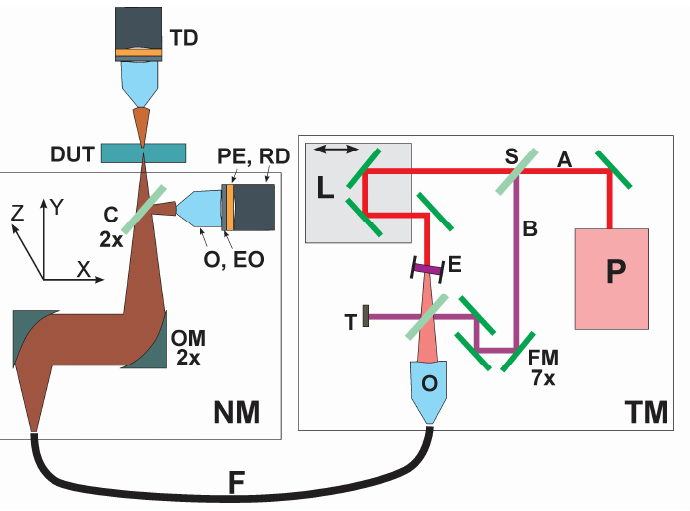
Figure 1. The optical circuit is mounted on an XYZ nanoscanner (not shown). Both reflection mode and transmission mode measurements are possible. Here, the sample remains stationary while the nanoscanner will scan the sample over a chosen area or volume. Adapted from [5]. Legends: P: Pump laser, L: Delay line, S: Beam splitter, A: Pump beam, B: Probe beam. E: T-ray emitter, FM: Fixed mirrors (7x), C: Beam combiner (2x), OM: Off-axis mirror (2x), O: Objective (3x), EO: Electro-optic sensor, PE: Polyethylene filter (2x), RD: Detector (reflection), TD: Detector (transmission), T: Beam stop, DUT: Device under test, TM: Terahertz module, NM: Nanoscanner module.